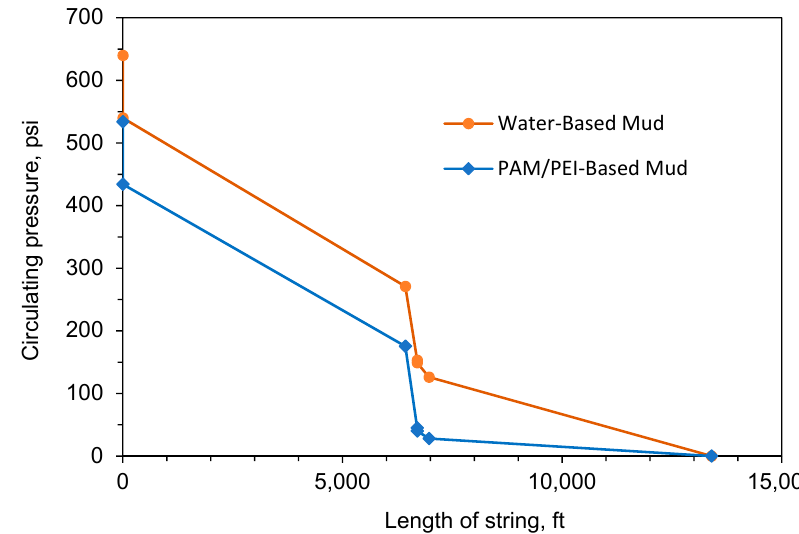
Figure 14. Circulating pressure vs. length of the string.